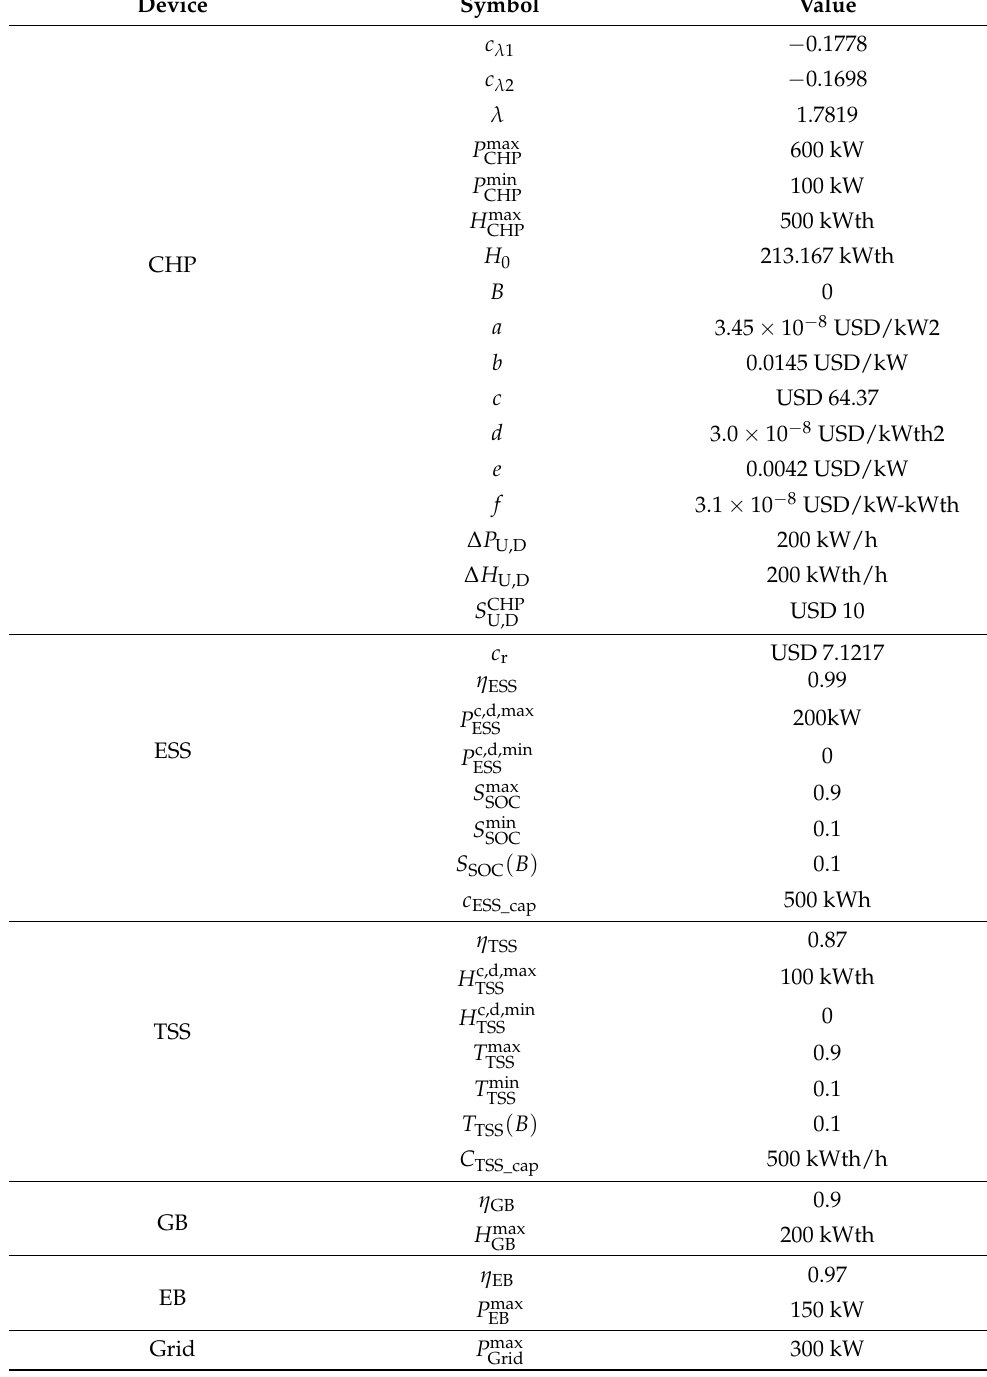
Table A1. Device